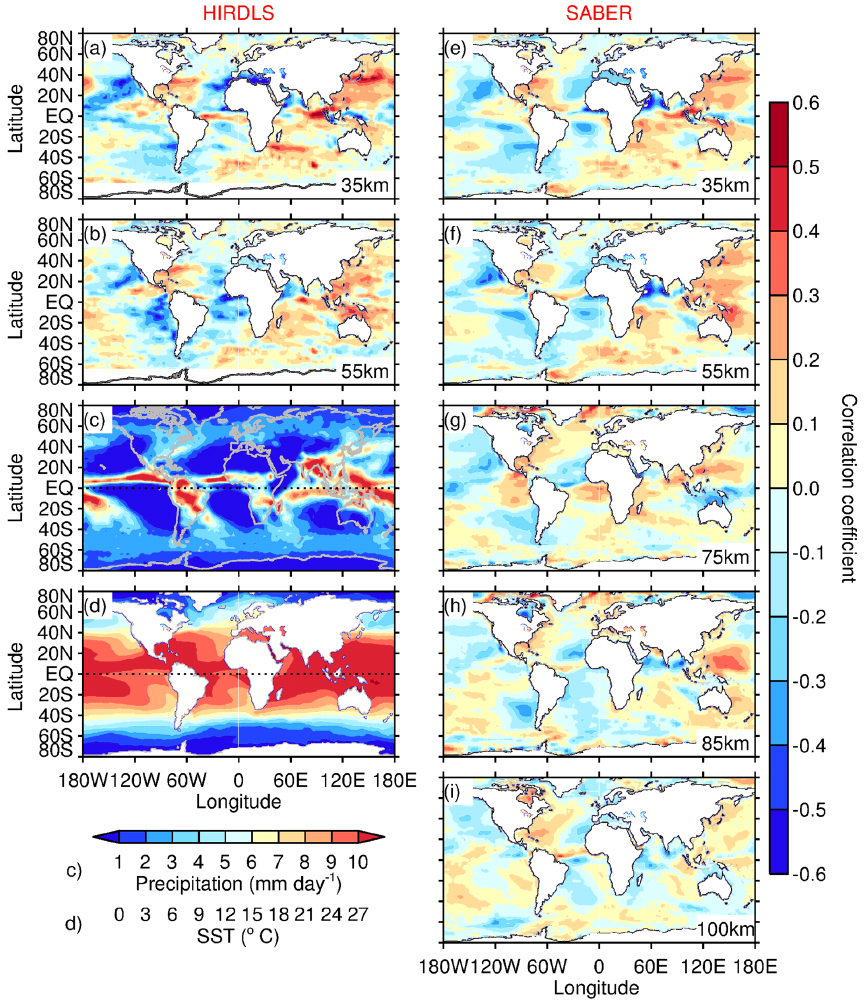
Figure 4. Global maps of zonally detrended correlations between SST and GWMF as well as summer composites of precipitation and SST. Panels (a) and (b) show zonally detrended correlations deduced from HIRDLS at 35 and 55km altitude, the right column shows results from SABER for 35, 55, 75, 85 and 100km altitude. For comparison, precipitation and SST distributions are given in panels (c) and (d) . Both maps show the distributions of the respective summer hemisphere, i.e., they show July values for the Northern Hemisphere and January values for the Southern